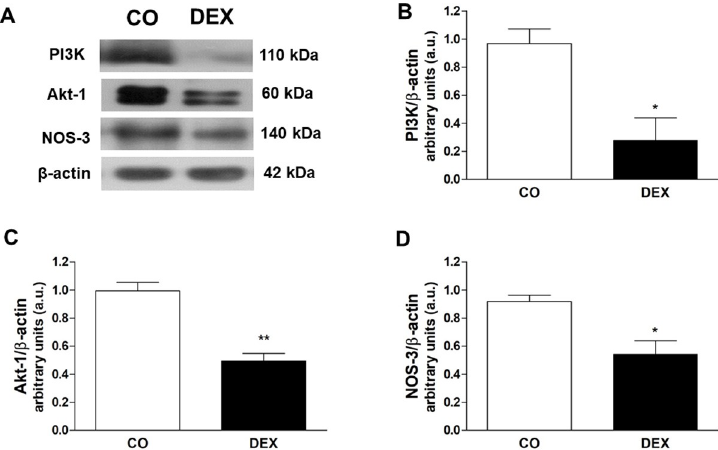
Fig 3. Effects of insulin resistance on PI3K, Akt and eNOS expression. (A), representative images of western blot and (B-D), quantitative analysis of total PI3K, Akt and eNOS protein levels in mesenteric artery of control (CO) and dexamethasone-treated (DEX) groups. The results are expressed as the mean ± SEM for 4 different samples from different animals in each group. For data analysis, Student’s unpaired t-test was used. � p < 0.05, �� p < 0.01, CO vs DEX.